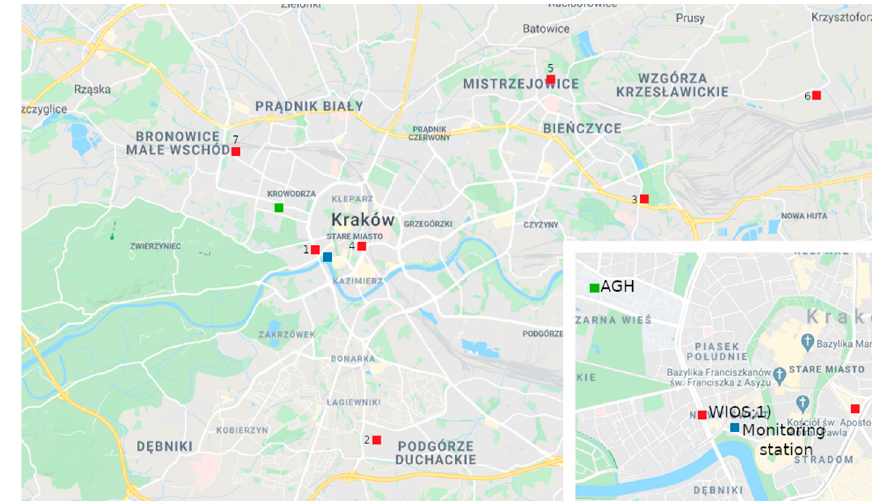
Figure 1. WIOS air quality station locations in Krakow.